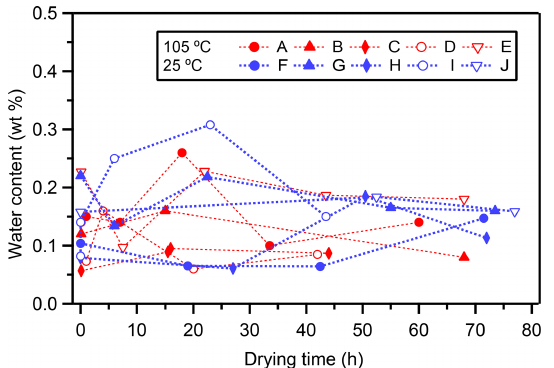
Figure 3. Changes in water content with increasing drying time. Changes in water content (in wt%) of each subsample with time (in hours). Symbols indicate the 105 ◦ C experiment (red, layer A–E) and 25 ◦ C drying experiment (blue, layer F–J).